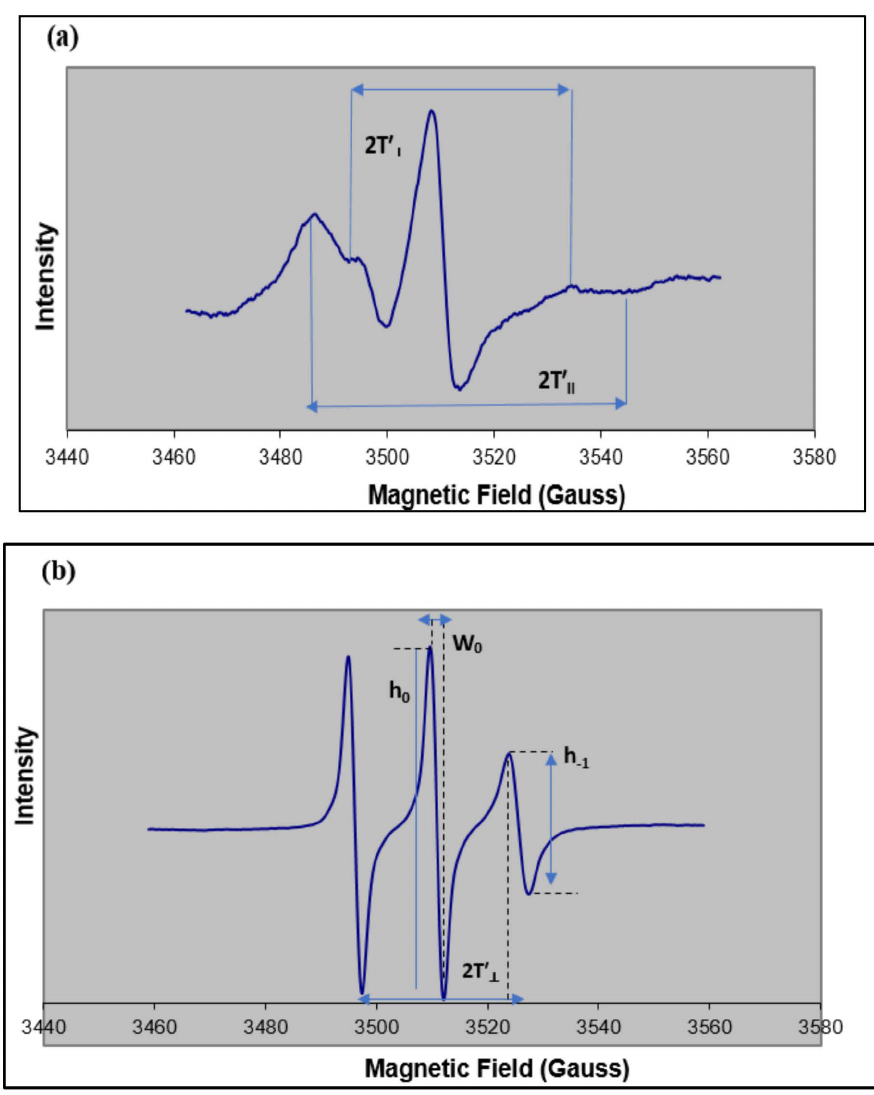
Figure 3. Example ESR spectra showing measurements used to describe membrane fluidity. ( a ) ESR- spectrum of the 5-DSA spin-label incorporated into liposomes (phospholipid:stearic acid:ceramide: cholesterol (1:1:1:1)) measured at room temperature. Shown are the parameters used to determine the order parameter, S. The location of the nadir of the high field offset needed to make the best estimate of 2T’ II is best accomplished when the vertical scale of the spectrum is expanded via the Bruker software. ( b ) ESR-spectrum of the 16-DSA spin-label incorporated in chloroform solvent (used as a reference for calculating parameters). Line heights and peak-to-peak line width (W 0 ) are used to calculate the rotational correlation time ( τ c ). All samples were at room temperature during collection of ESR